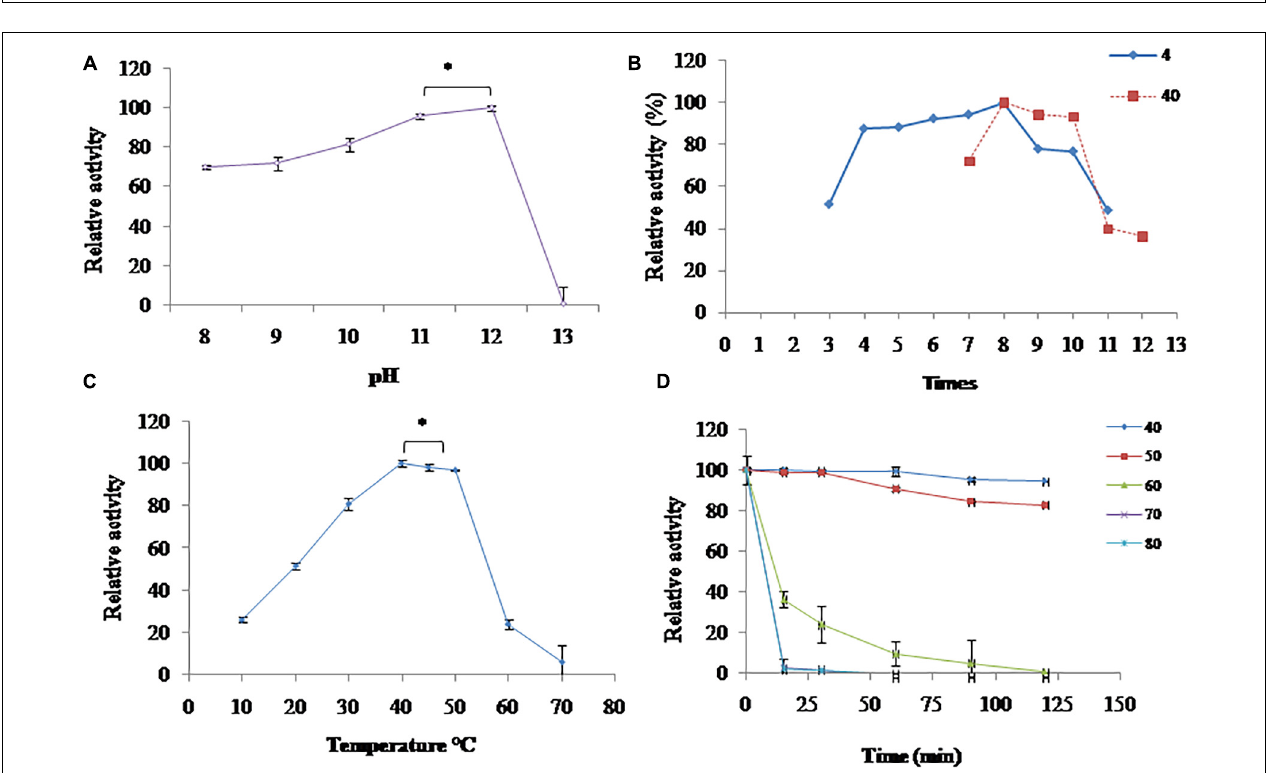
FIGURE 3 | Characterization of extracellular proteases: (A) pH optimum; (B) pH stability; (C) temperature optimum; and (D) temperature stability. *Significant difference.